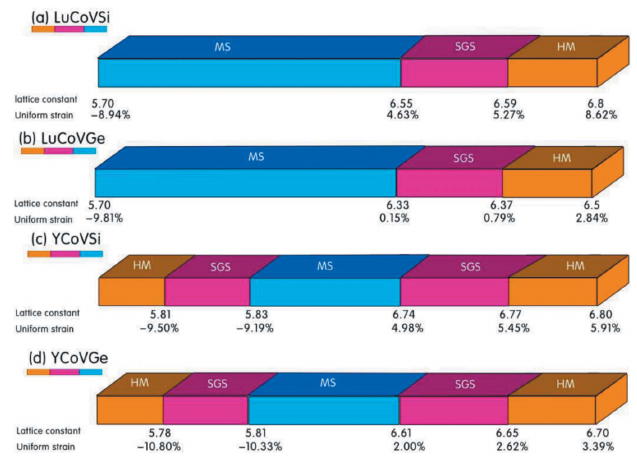
Figure 7 ( a ), ( b ) The MS ! SGS ! HM transitions under uniform strain for